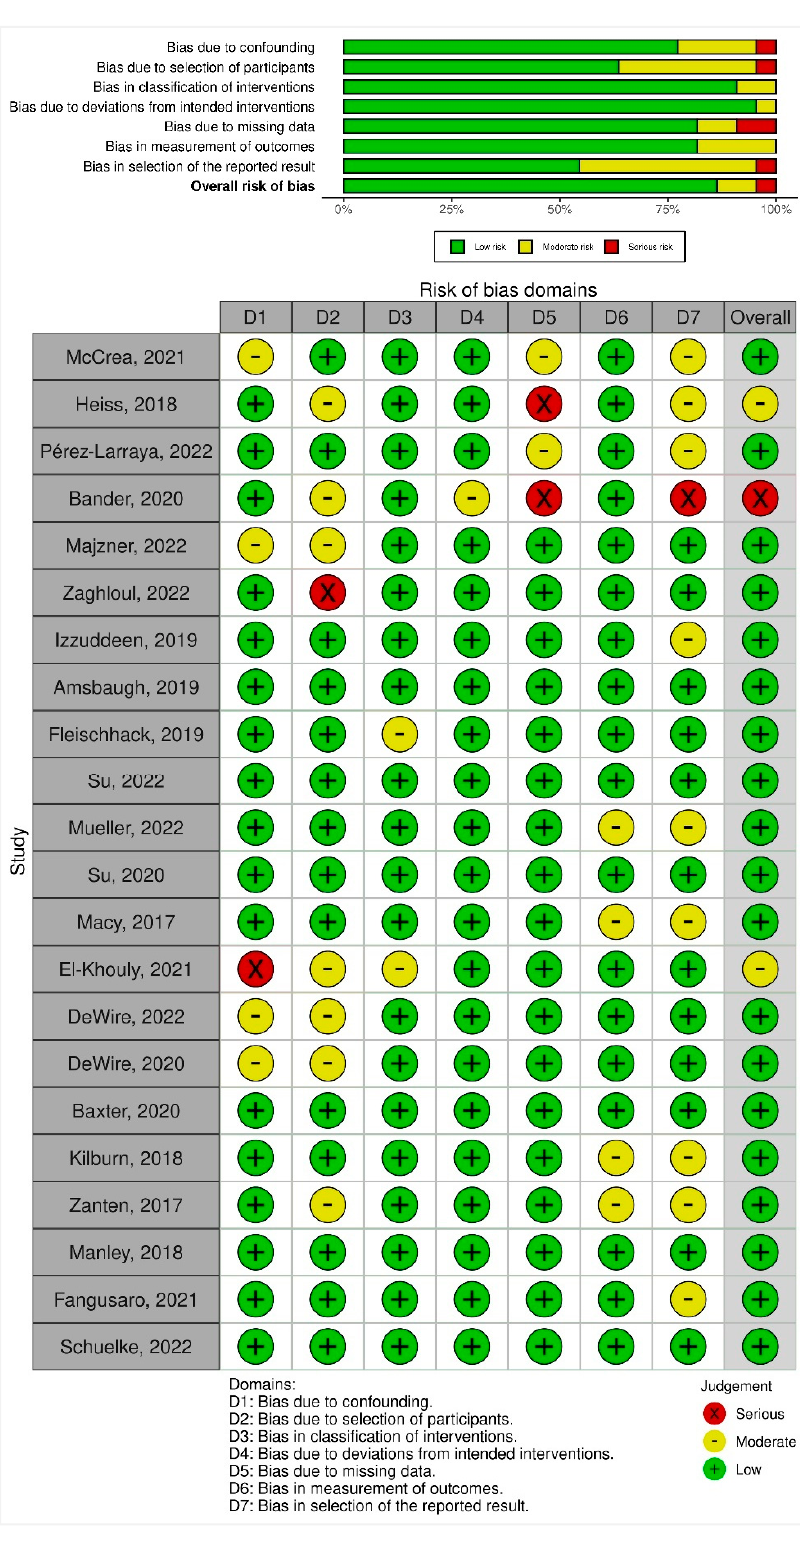
Figure 2. Summary plot and traffic light plot depicting risk of bias among the included studies [13–